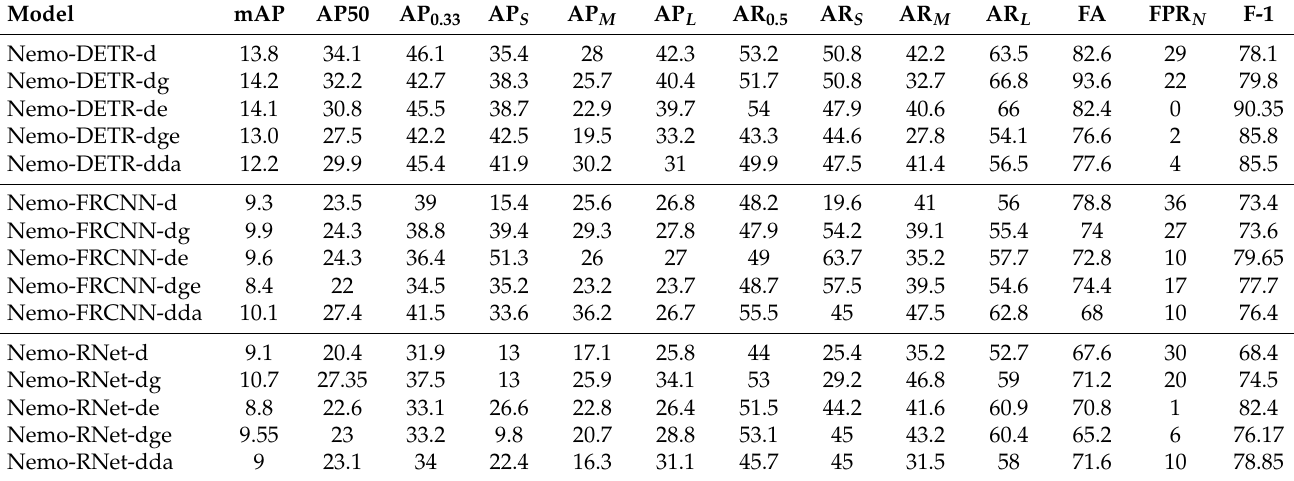
Table 7. Wildfire smoke density detection results. Wildfire smoke detection results. Three different models, DETR, FRCNN, and RetinaNet (RNet) were trained with our dataset (Nemo) using the data configurations from Table 2 (d, dg, de, dge, and